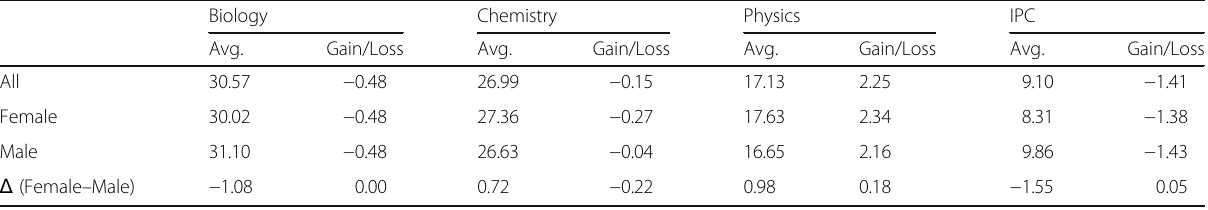
Table 6 Six-year average enrollment rates and gain/loss of enrollment by gender in required and selective science courses Biology Chemistry